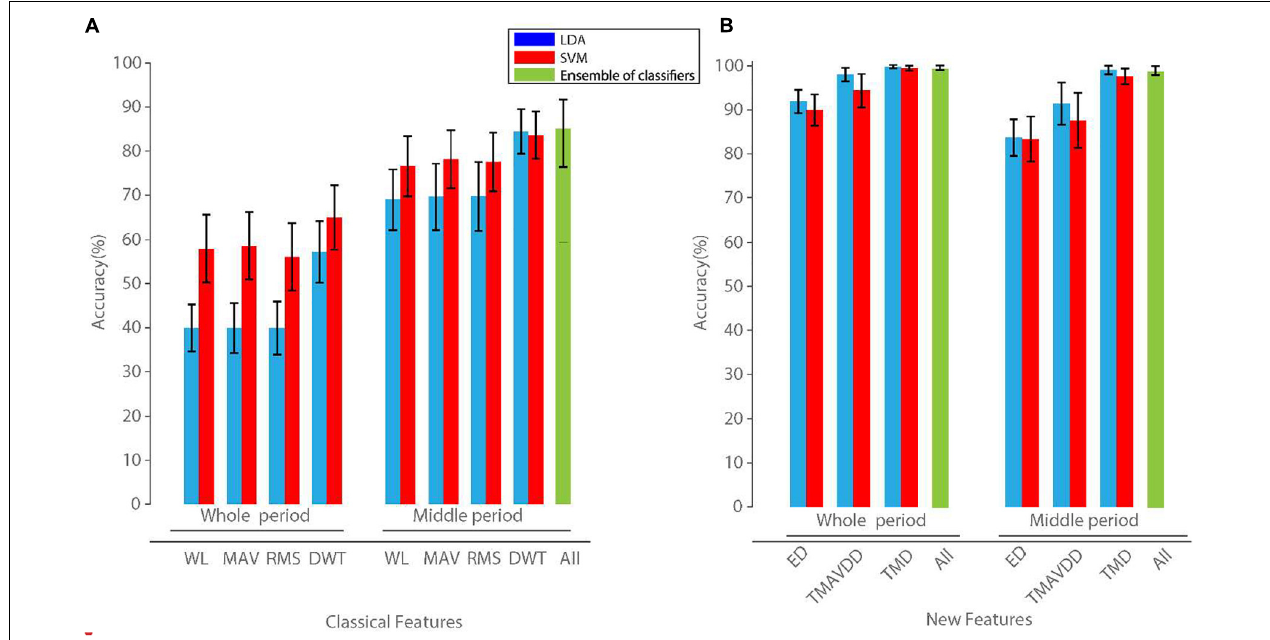
FIGURE 2 | The overall classification accuracy of three new features individually as well as their combination (A) , and classic features (B) in the whole and also middle period of recording in the intact subjects. Individual features were classified using linear discriminant analysis (LDA) and support vector machine (SVM), and ensemble of LDA, SVM, and multi-layer perceptron (MLP) classifiers. The results of the MLP classifier were not shown as they were very low, compared to those of LDA and SVM. Error bars show standard deviation over the test folds. WL, waveform length; MAV, mean absolute value; RMS, root mean square; DWT, discrete wavelet transform; ED, Entropy of density; TMD, Trimmed Mean of Density; TMAVDD, trimmed mean absolute value of derivative density.